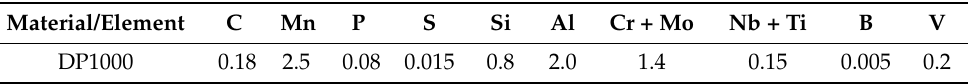
Table 1. Chemical composition of AHSS; maximal concentrations of elements in wt.%.